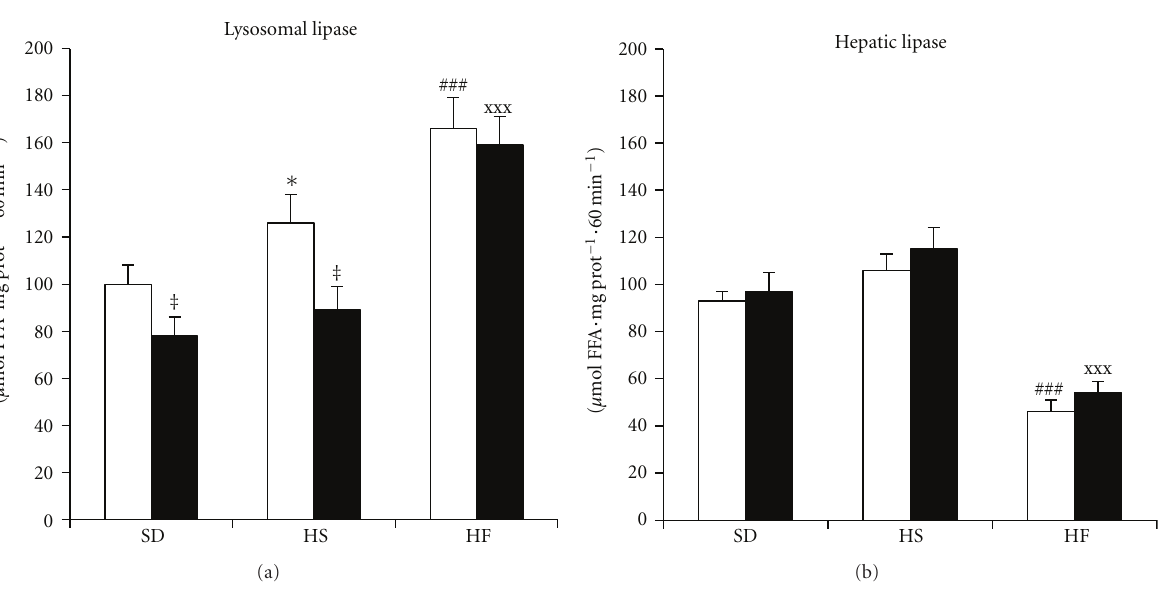
Data are expressed in nmol palmitic acid per g tissue and given as mean ± SEM n = 6. ∗ P < 0 . 05, ∗∗ P < 0 . 01 HS fasted versus SD fasted; † P < 0 . 05, ††† P <